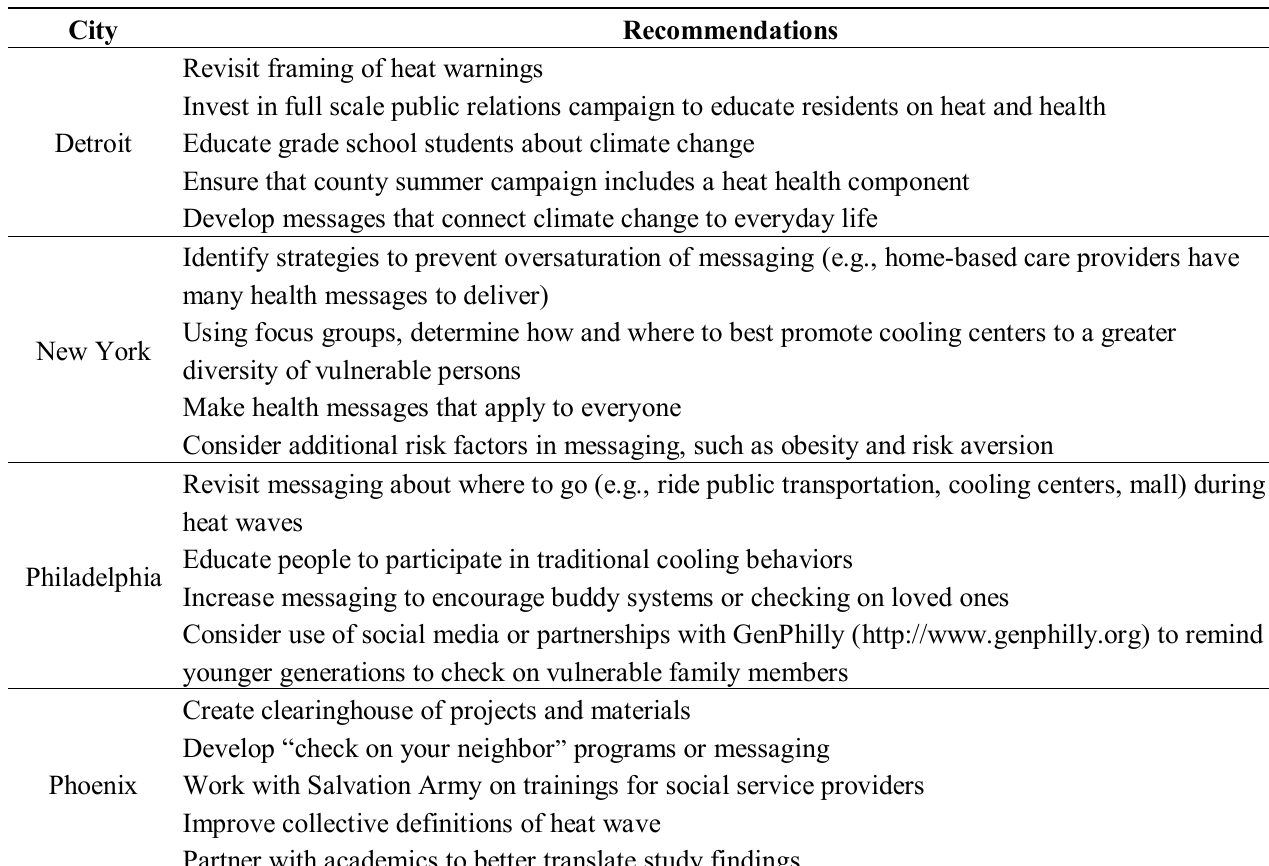
Table 2. Summary of workshop